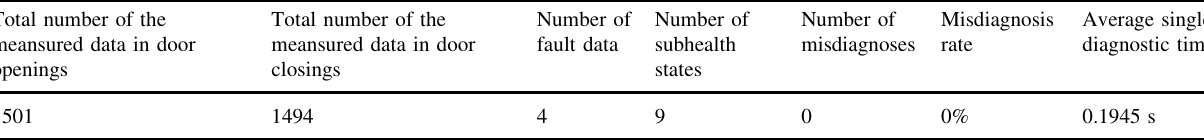
Table 13 Statistics of misdiagnosis rate of typical subhealth rules of random samples Total number of the meansured data in door openings